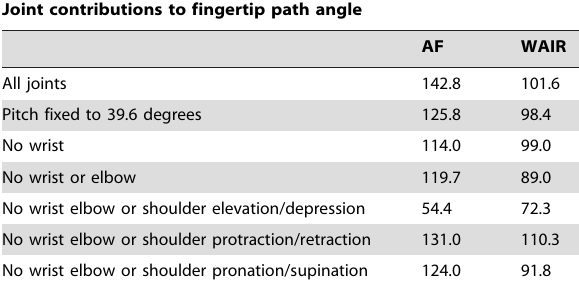
Table 6. Angle in degrees of the fingertip path of the right forelimb in lateral